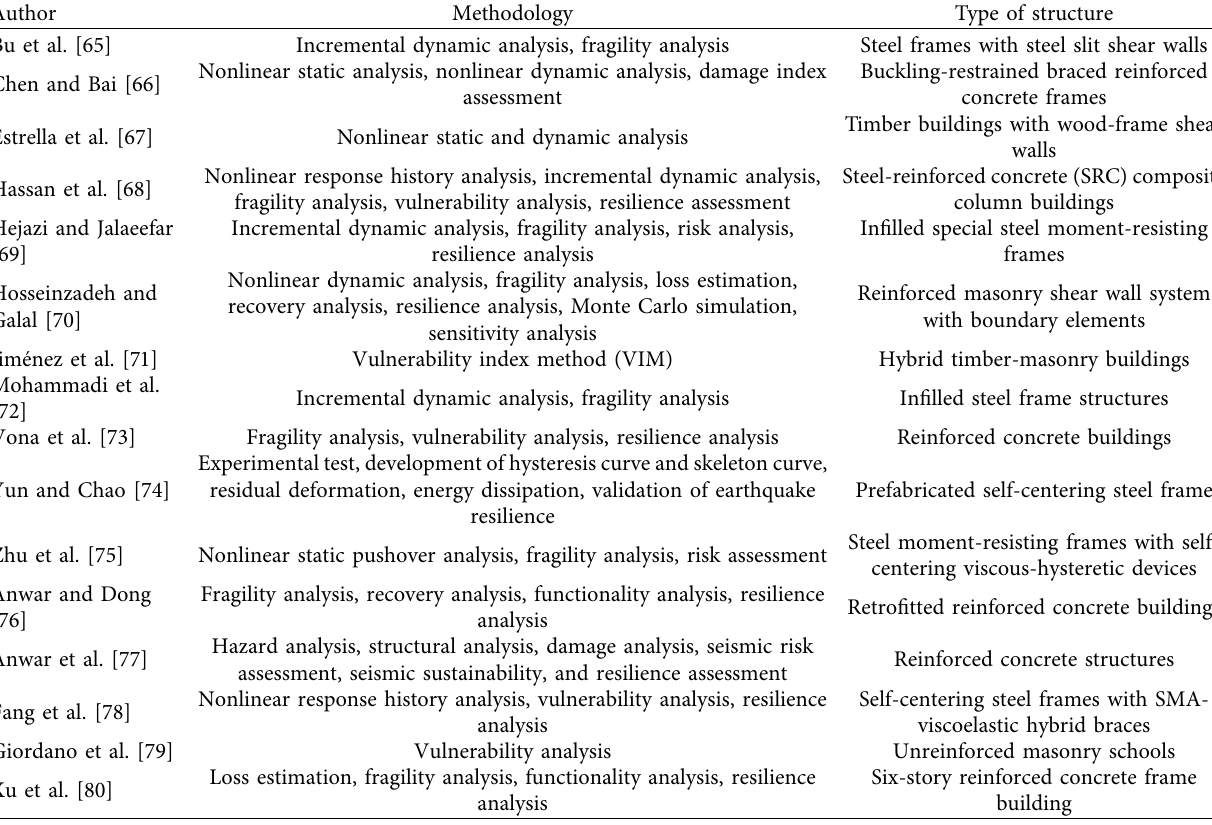
Table 5: Seismic resilience case studies applications on different building